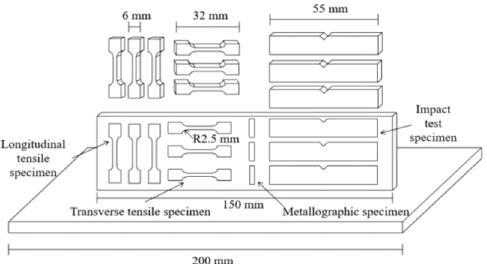
1: Test method”. Three groups of impact samples were cut along the processing direction, and the impact absorption energy was measured and averaged.